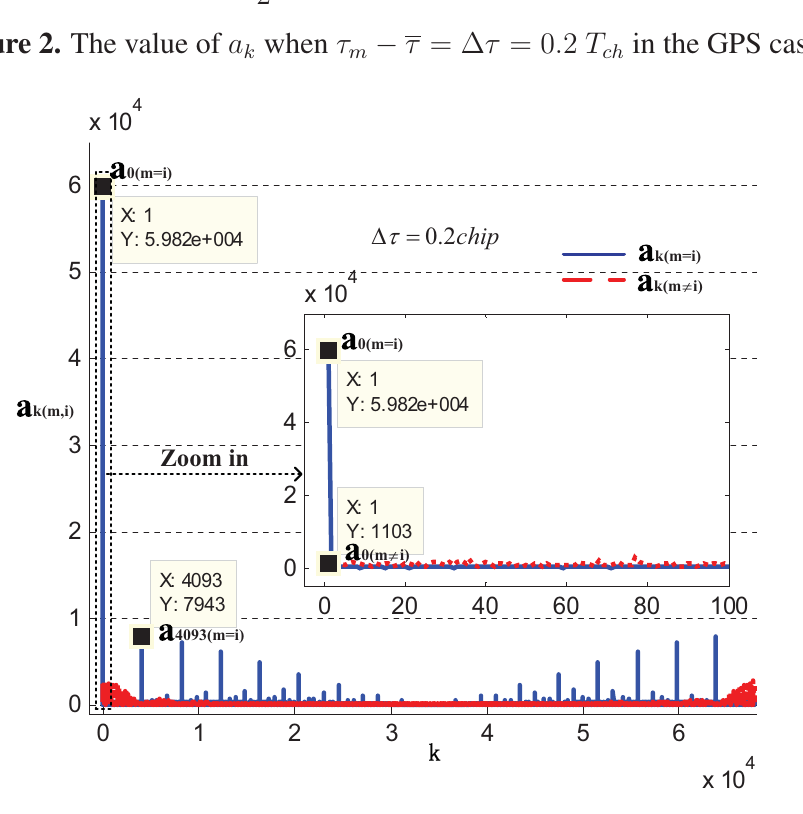
Figure 3. The combination of sinc